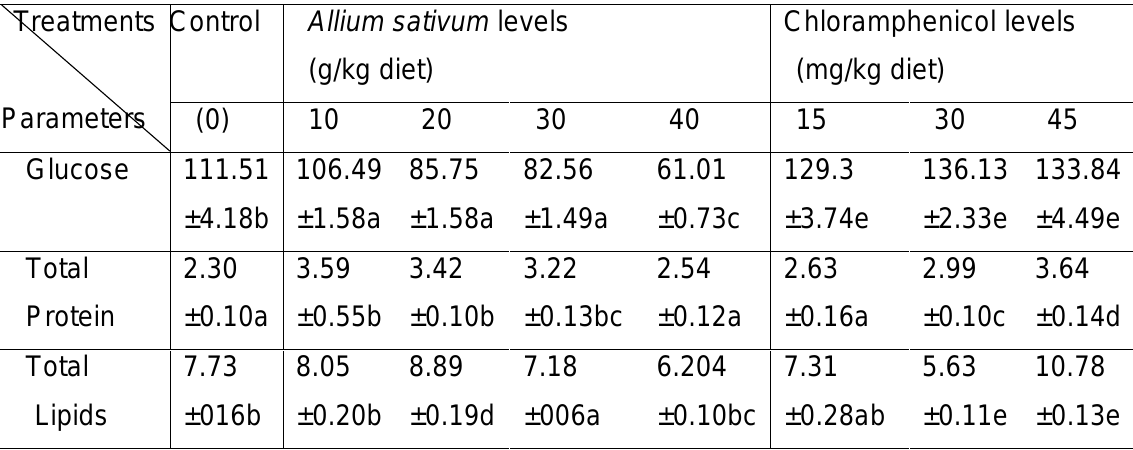
Means with the same letters in the same row were not significantly different (p>0.05). Data are represented as mean ± SE; n=5.